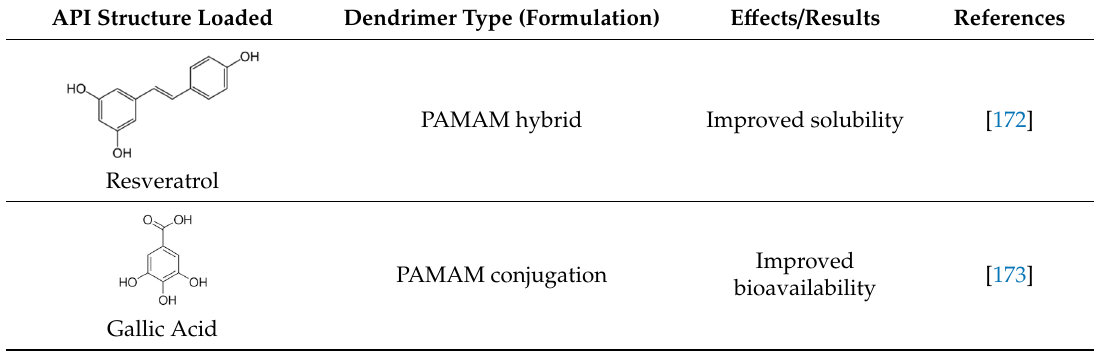
Table 5. Anti-oxidant Compounds.